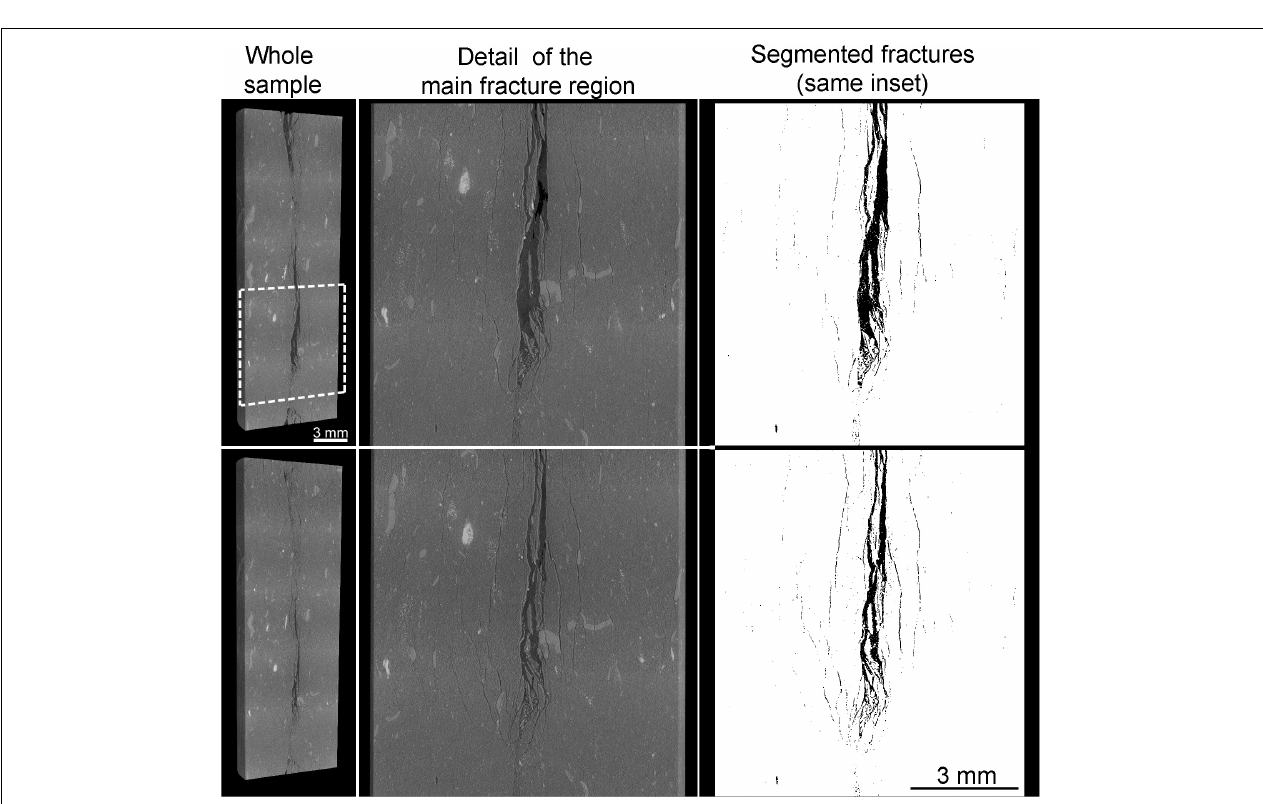
FIGURE 2 | Vertical section of the sample before and after hydraulic sealing. On the middle column, a detail of the part of the sample with the choke point and a large aperture section of the fracture are displayed. On the right, corresponding binarized images further highlight the fracture morphology in the sample.